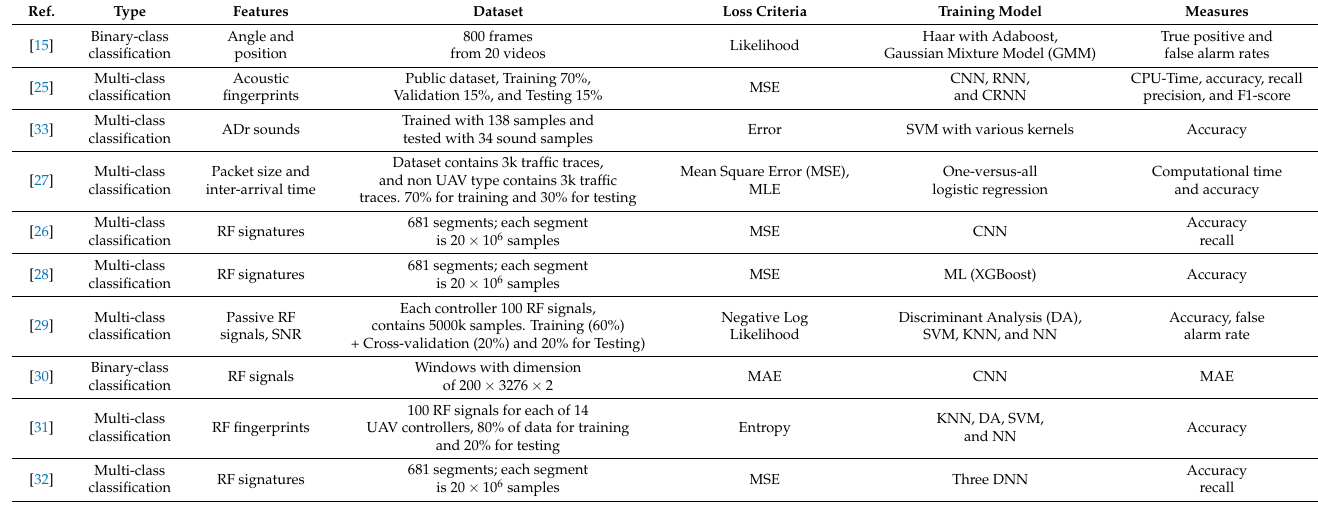
Table 2. Summary of the Unmanned Aerial Vehicle (UAV) detection approaches based on Machine Learning (ML).